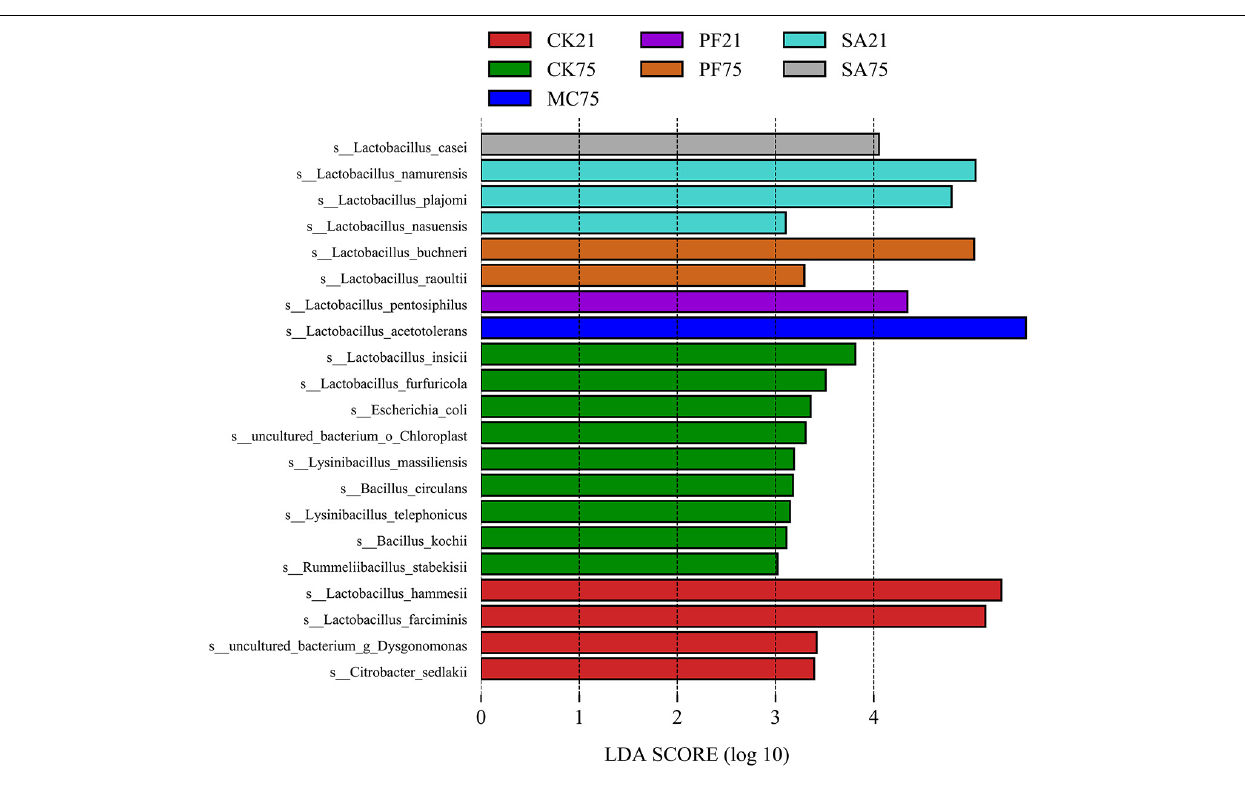
Frontiers in Microbiology |